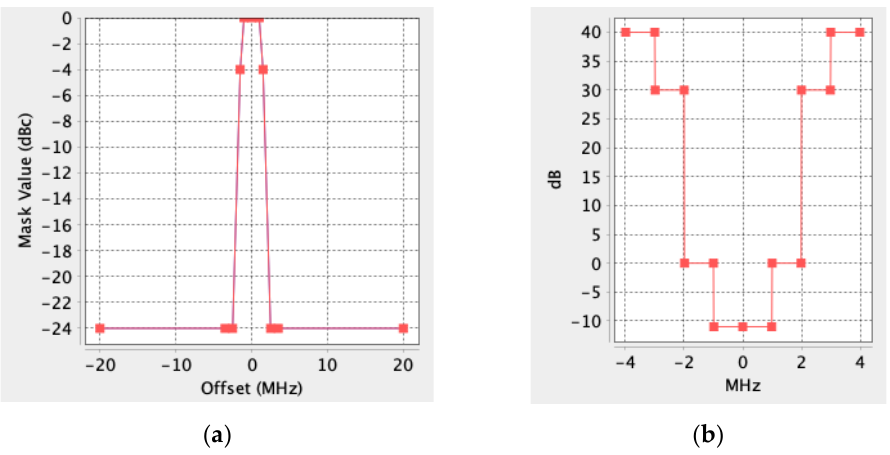
Figure 5. Bluetooth: ( a ) transmitter emission mask; and ( b ) receiver-blocking mask.